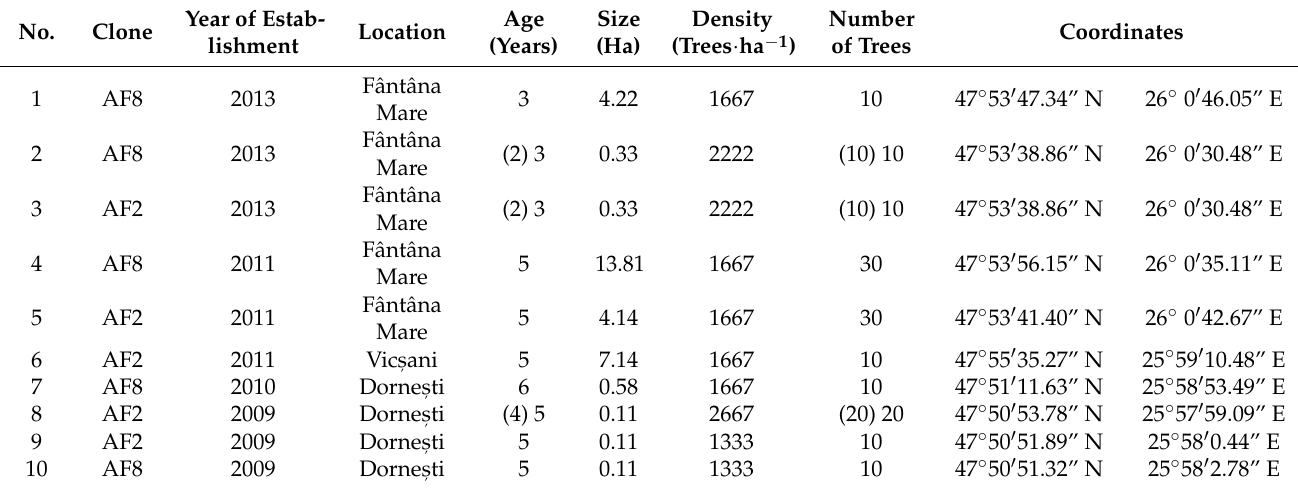
Table 1. Summary data of the analysed poplar crops.